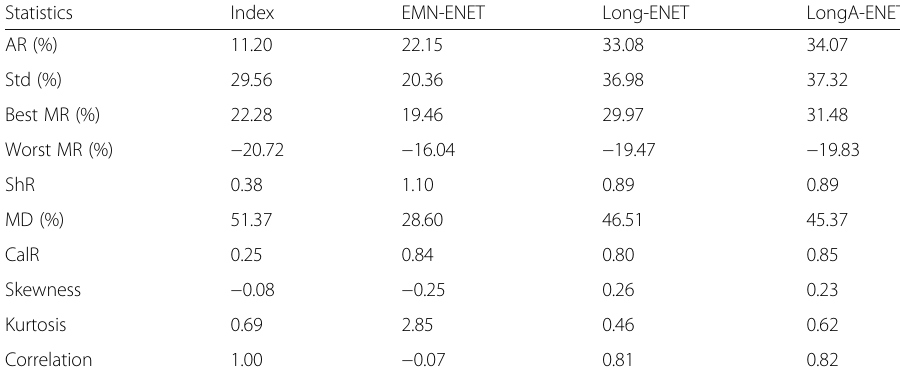
Table 4 Average performance measures during 2003 – 2015 for 5-year rolling windows